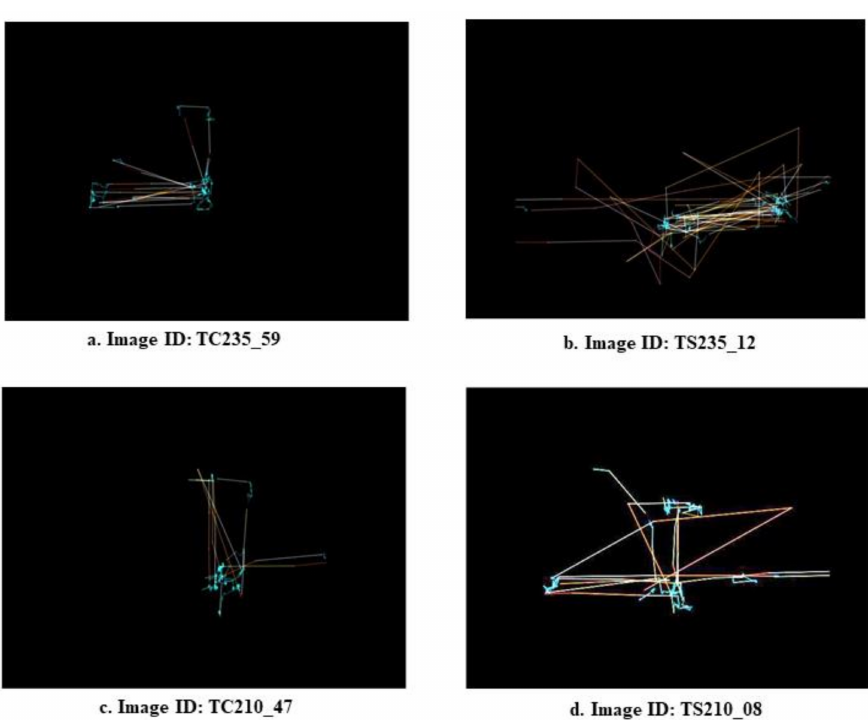
Figure 1. ETSP images from the dataset as examples (images on the left side for a TD participant and images on the right side for an ASD diagnosed participant—Image ID’s as given in the dataset).